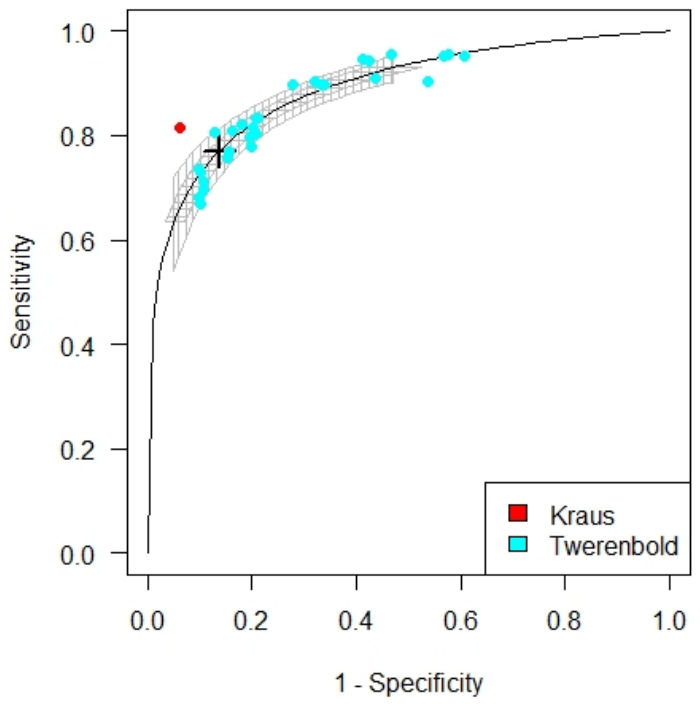
Figure 7. SROC curve for the optimized troponin I cut-off for patients without dialysis. Table 3 shows all the different estimated cut-offs with the respective sensitivity, speci- ficity, AUC, and CI values. Table 3. Different troponin cut-offs established by meta-analysis for the systematic review of cut-off values for troponin in patients with chronic kidney disease.